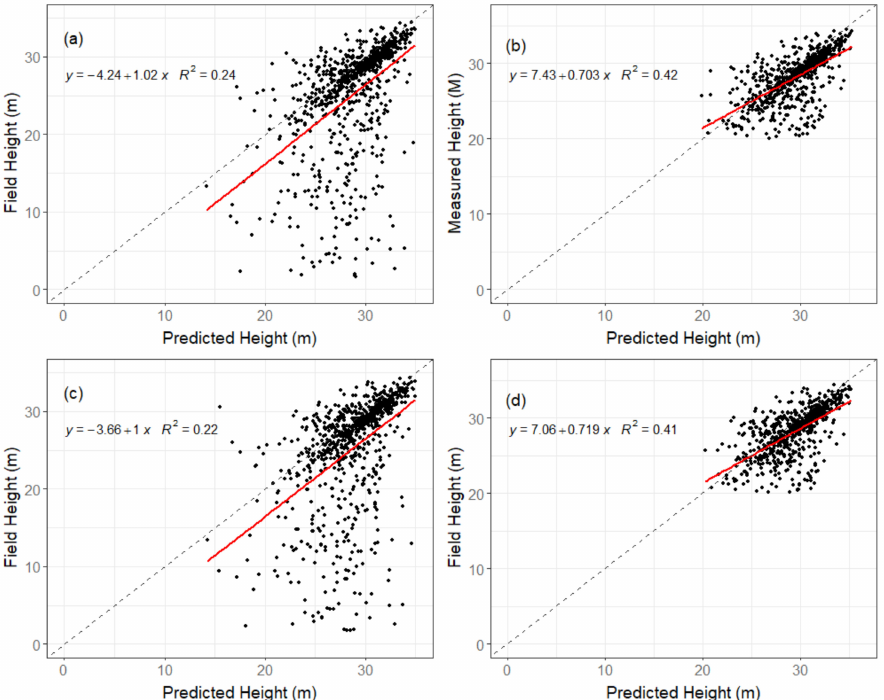
Figure 14. Correlation between field-measured and ( a ) all ULS-derived heights, ( b ) all MLS-derived heights, ( c ) ULS-derived heights with all suppressed trees removed and ( d ) MLS-derived heights with all suppressed trees removed. The dashed lines represent a 1:1 line and the red lines represent a fitted linear model with the linear equation and R 2 .